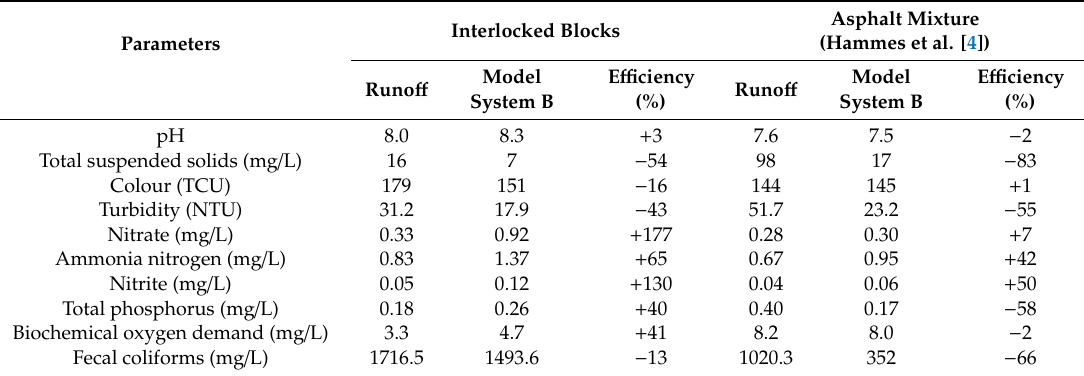
Table 7. Comparison of quality results for model system